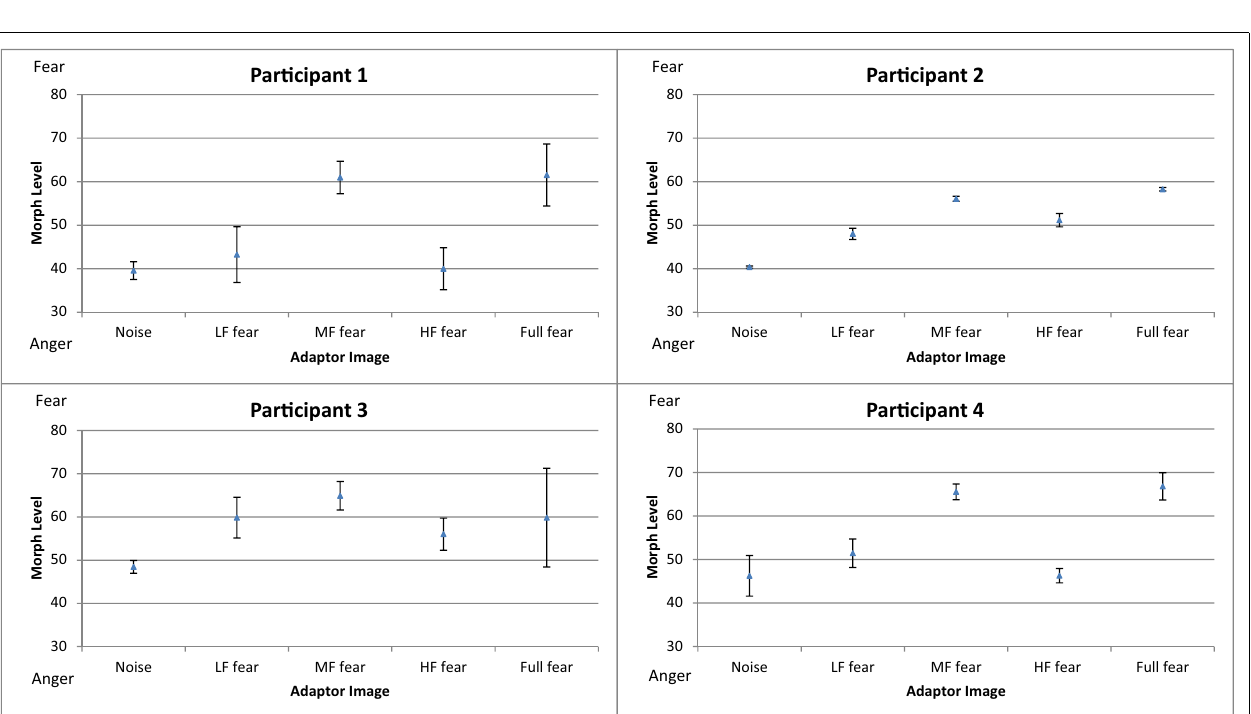
(from the full-bandwidth morph range) is then displayed for 1s, and the screen presents a gray background until a binary response (anger or fear) is made. All adaptors and test images are rotated in a randomized direction with a diameter of 1˚ of visual angle around the center of the screen.